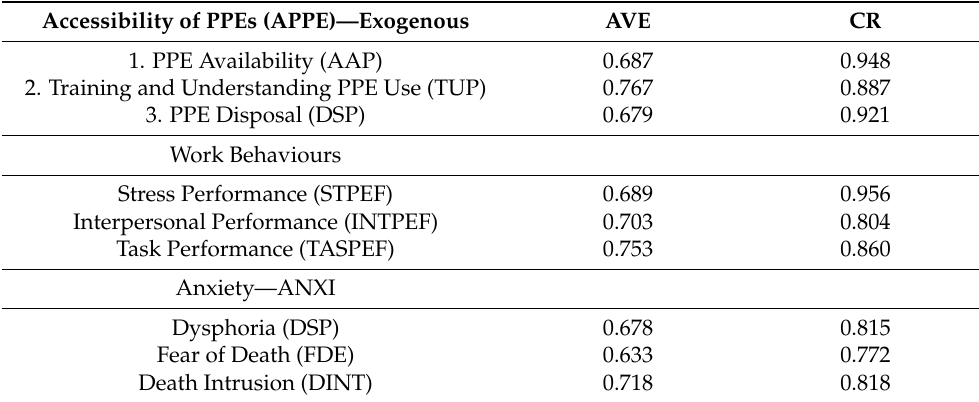
Table 3. Results of convergence validity of